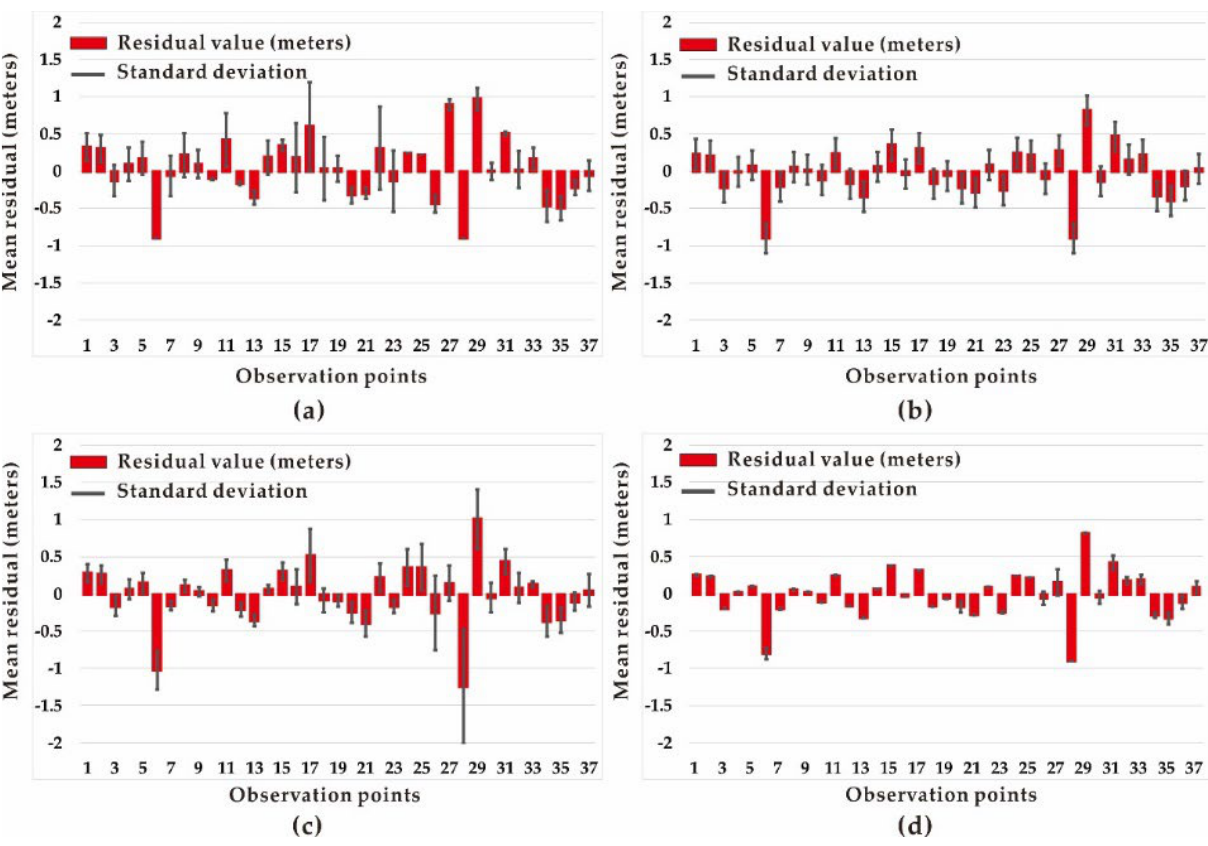
Figure 5. Mean residual of the four designs of pilot point emplacement over the ten iterations: ( a ) regular placement with 35 pilot points; ( b ) MHMDG placement with 35 pilot points; ( c ) regular placement with 60 pilot points; ( d ) MHMDG placement with 60 pilot points.